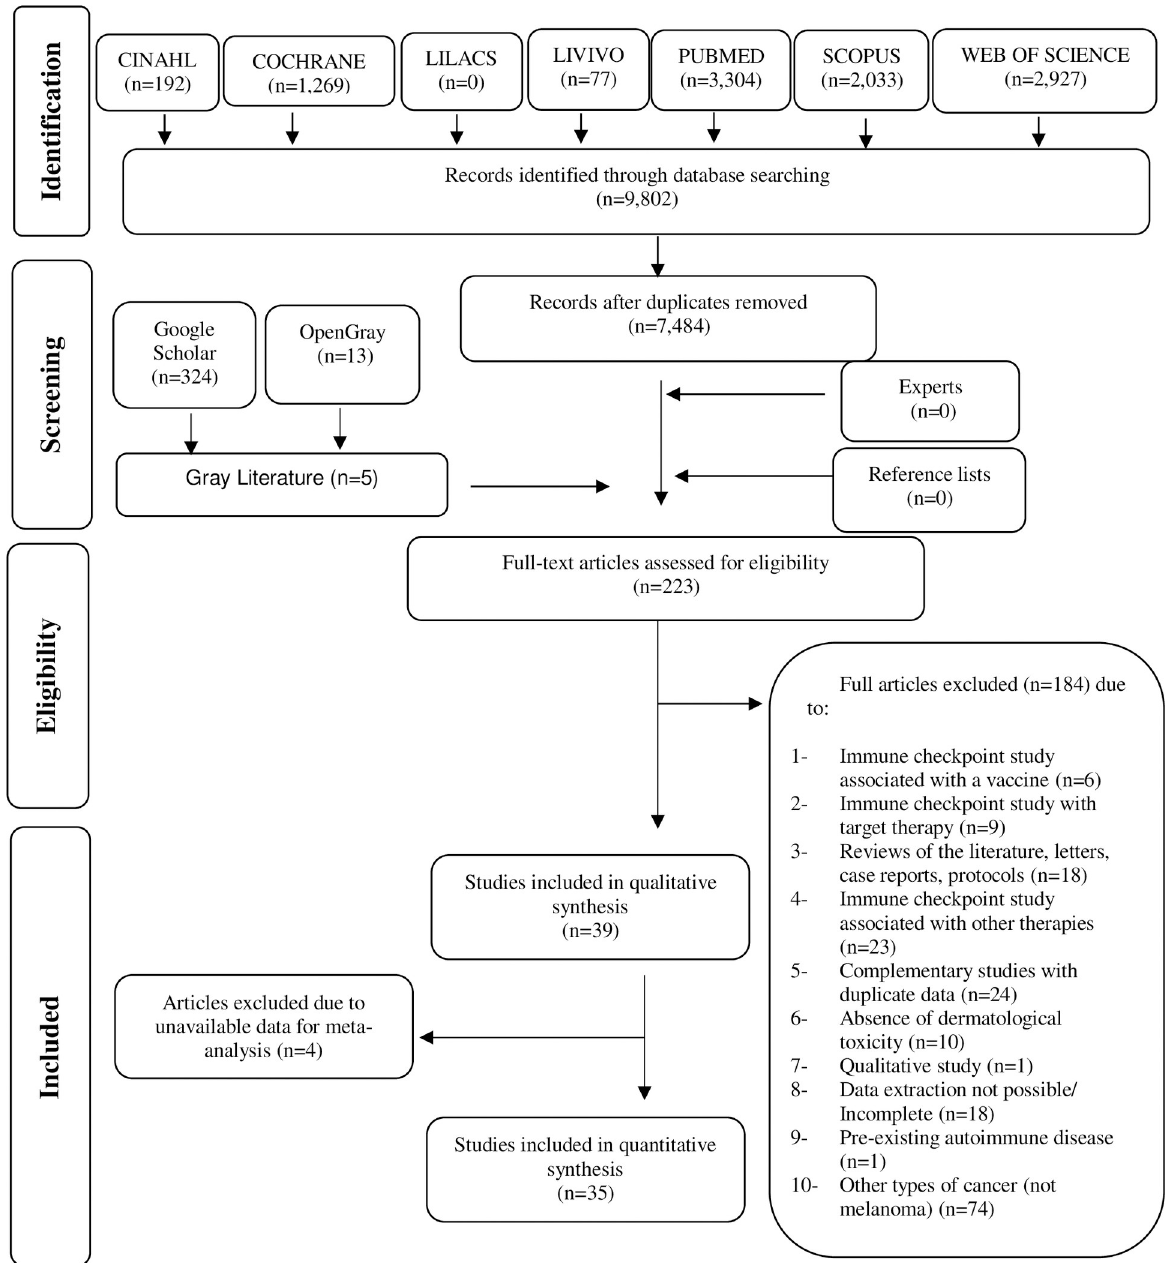
Fig 1. Flow diagram of the literature search and selection criteria. Adapted from